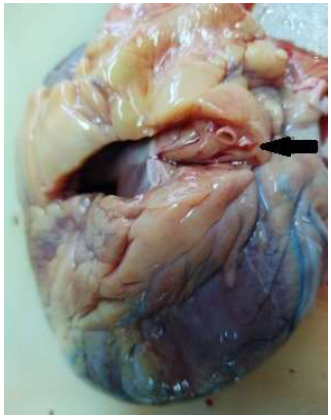
Figure 1. EAT thickness for Cx incision.